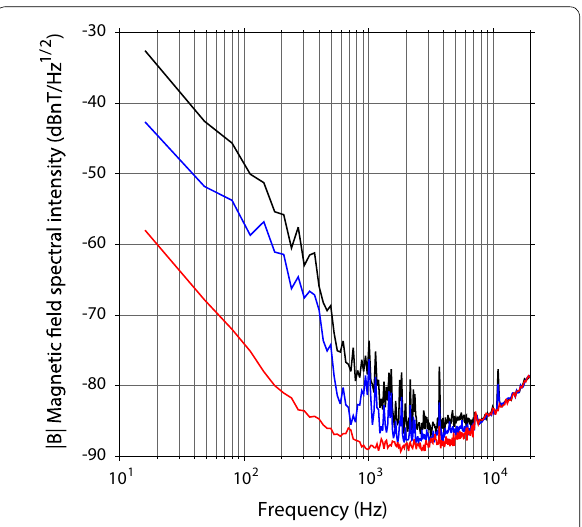
Fig. 16 Magnetic field spectral intensity during the extension opera- tion for the MAST. The black, blue, and red lines are the typical intensi- ties before extension, during partial extension, and after full extension